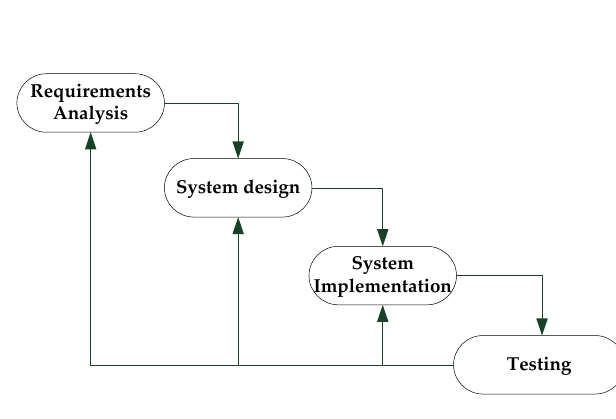
Figure 1. Waterfall model.